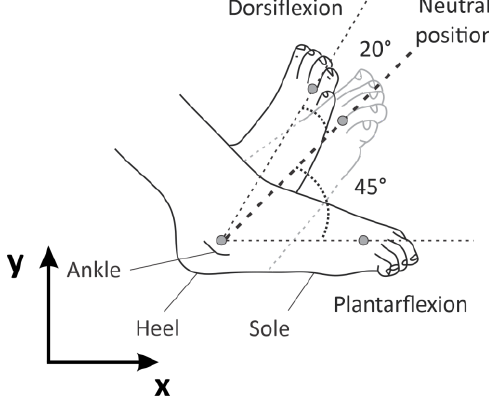
Figure 1. Ankle rehabilitation movements.